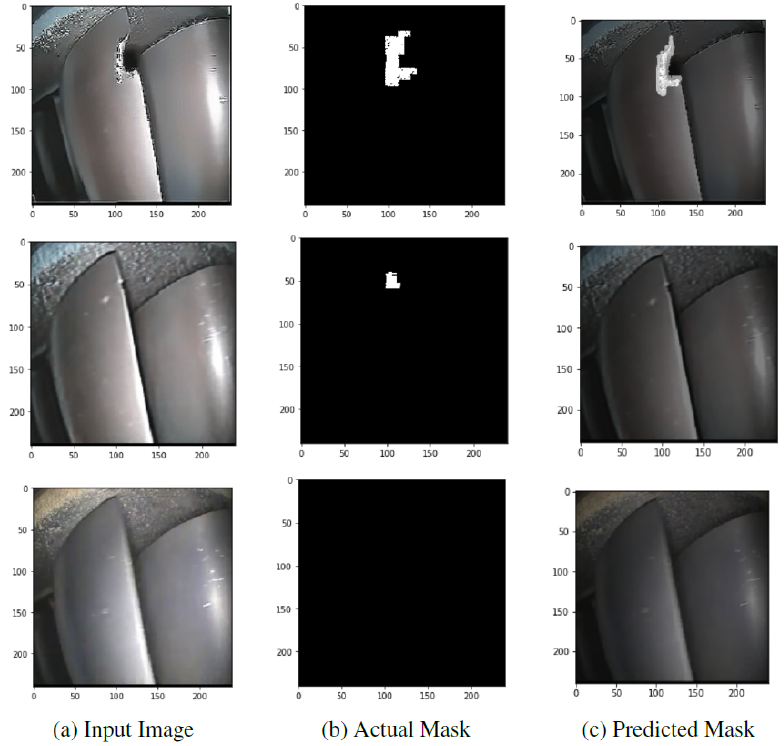
Figure A2. BCE segmentation on test data after 150